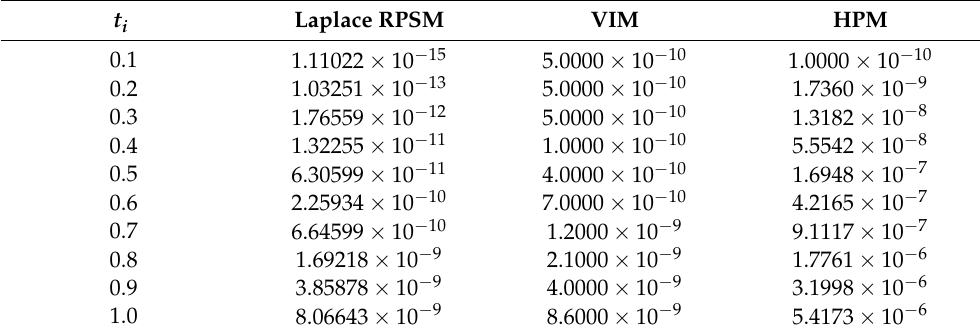
Table 5. Numerical comparison of 5-th approximate solution IVP (17),